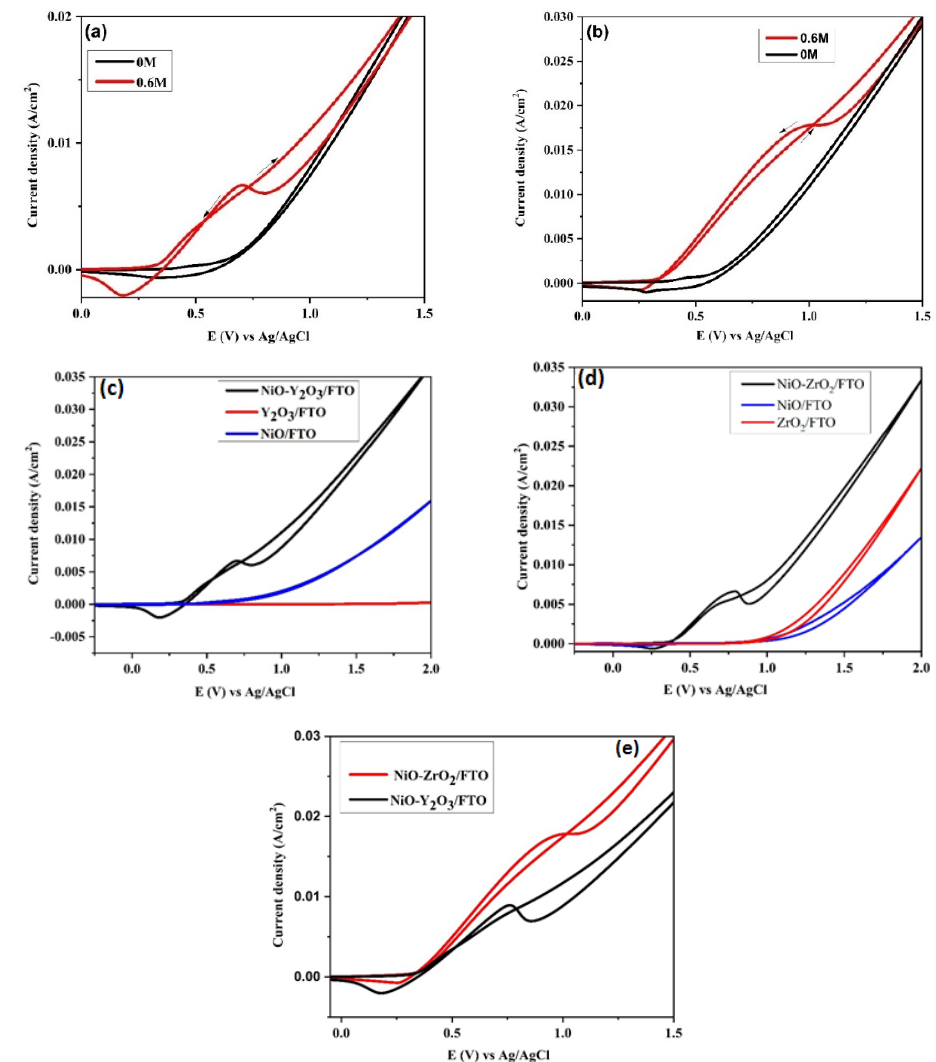
Figure 3. ( a ) Cyclic voltammogram of ( a ) NiO-Y 2 O 3/ FTO ( b ) NiO-ZrO 2 /FTO thin films in 0.5 M NaOH solution in absence and presence of 0.6 M methanol. Comparison of cyclic voltammogram of ( c ) NiO/FTO and Y 2 O 3 /FTO with NiO–Y 2 O 3 /FTO and ( d ) NiO/FTO and ZrO 2 /FTO with NiO- ZrO 2 /FTO thin films using 0.6 methanol, respectively. ( e ) Comparison of cyclic voltammogram of NiO-Y 2 O 3 /FTO and NiO-ZrO 2 /FTO thin film using 0.6 M at 100 mV/s.